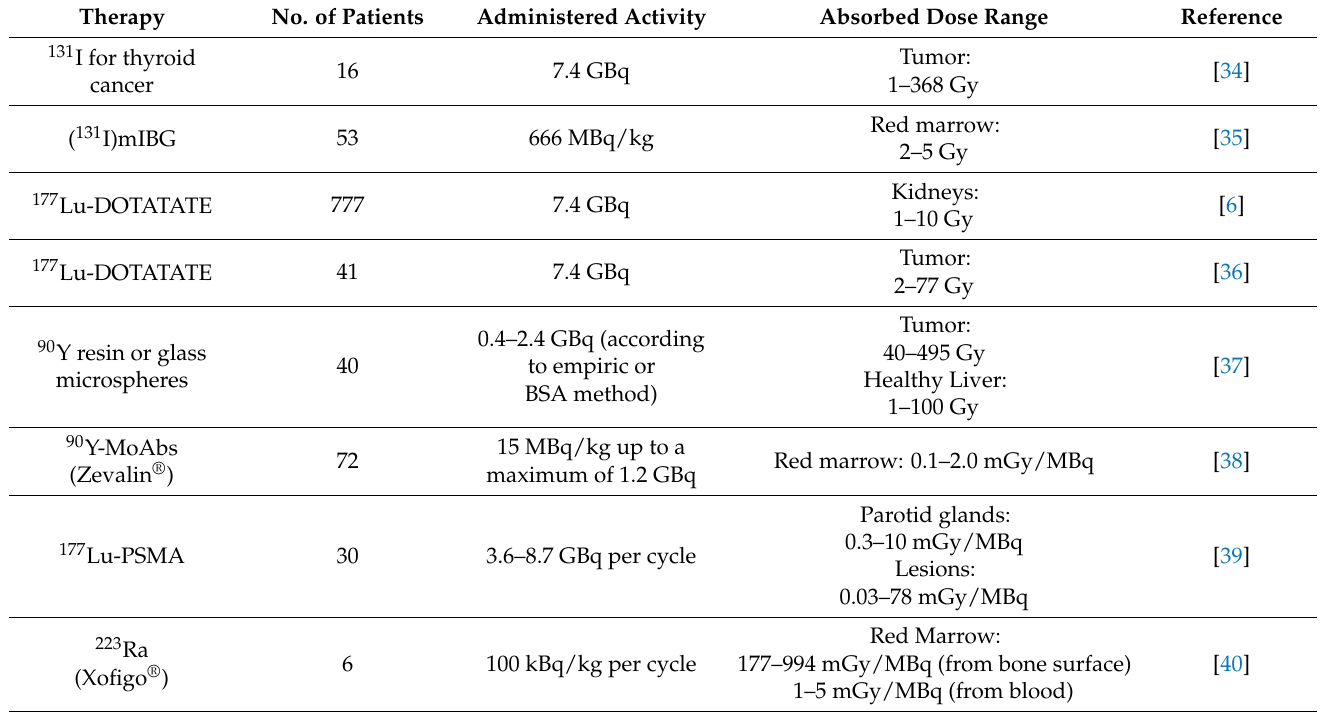
Table 2. Examples of the variability in the absorbed doses following different TRT treatments reported by some